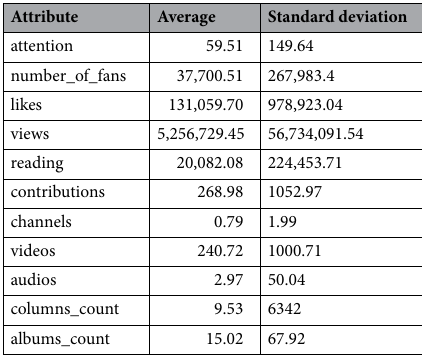
Table 2. Statistics of related attributes.